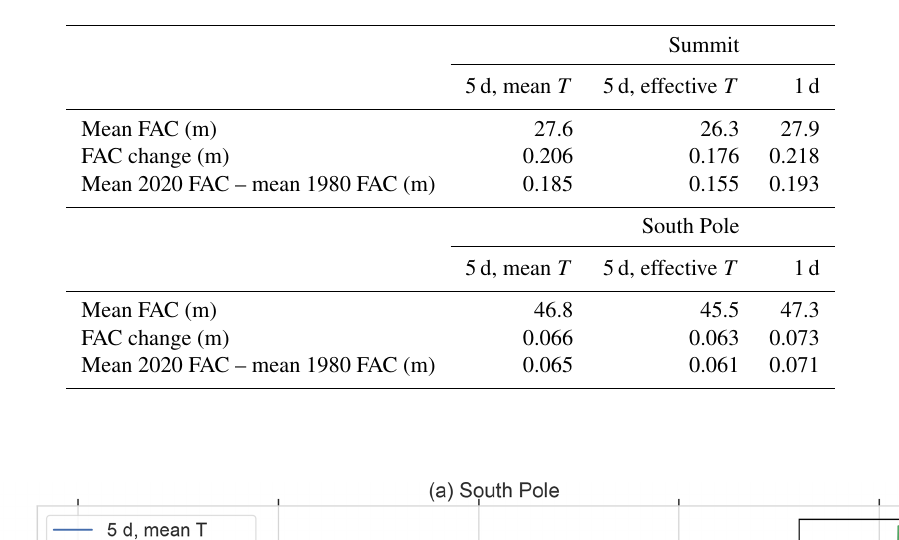
Table C1. The mean FAC, change in FAC, and 2020 mean FAC minus 1980 mean FAC predicted for each of the three model run types, for each site. The 5d mean T results are closer to the 1d results than the 5d effective T method.